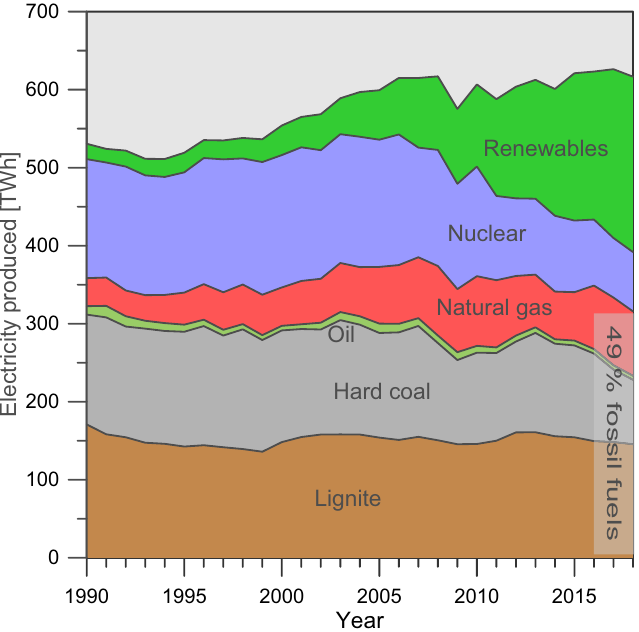
Figure 1. Gross electric power generation in Germany and share of the individual energy sources since 1990. Fossil fuels contribute nearly 50% to the electric power mix in 2018 (data source:AGEB 6 ).